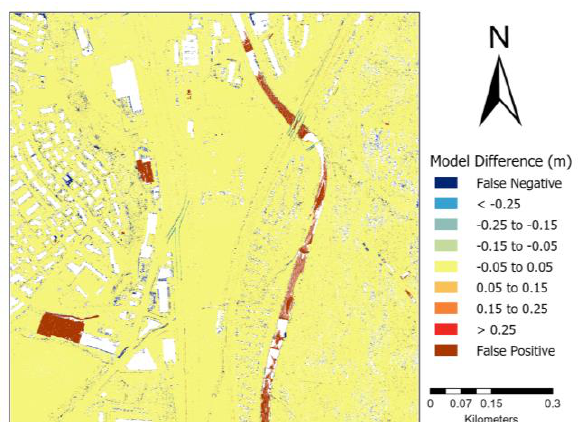
Figure 7 . The grid wise comparison between DEMs (0.5 m) generated by the Vo-SmoG and reference data.